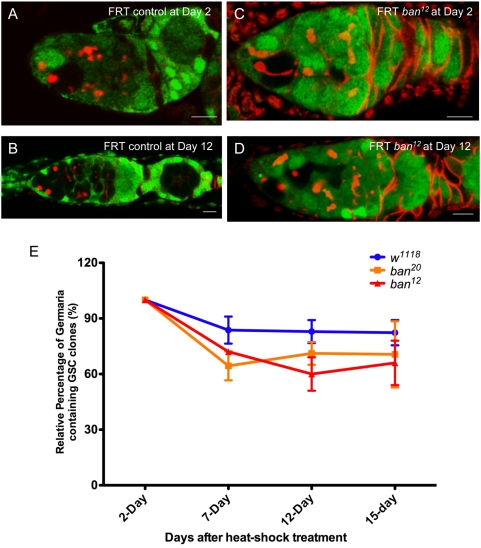
The bantam miRNA plays a non-autonomous role in GSC maintenance.GSC clones were induced by heat-shock treatment in adult female flies. Ovaries from FRT control flies (A and B) and FRT, ban flies (C and D) were dissected at day 2 and day 12 following heat-shock treatment; GSC clones were identified by the lack of GFP expression. Scale bar represents 10 µm. (E) Relative percentages of negatively GFP-marked GSC clones in FRT control and two FRT; ban null alleles at days 2, 7, 12, and 15 AHST are shown. P>0.5.